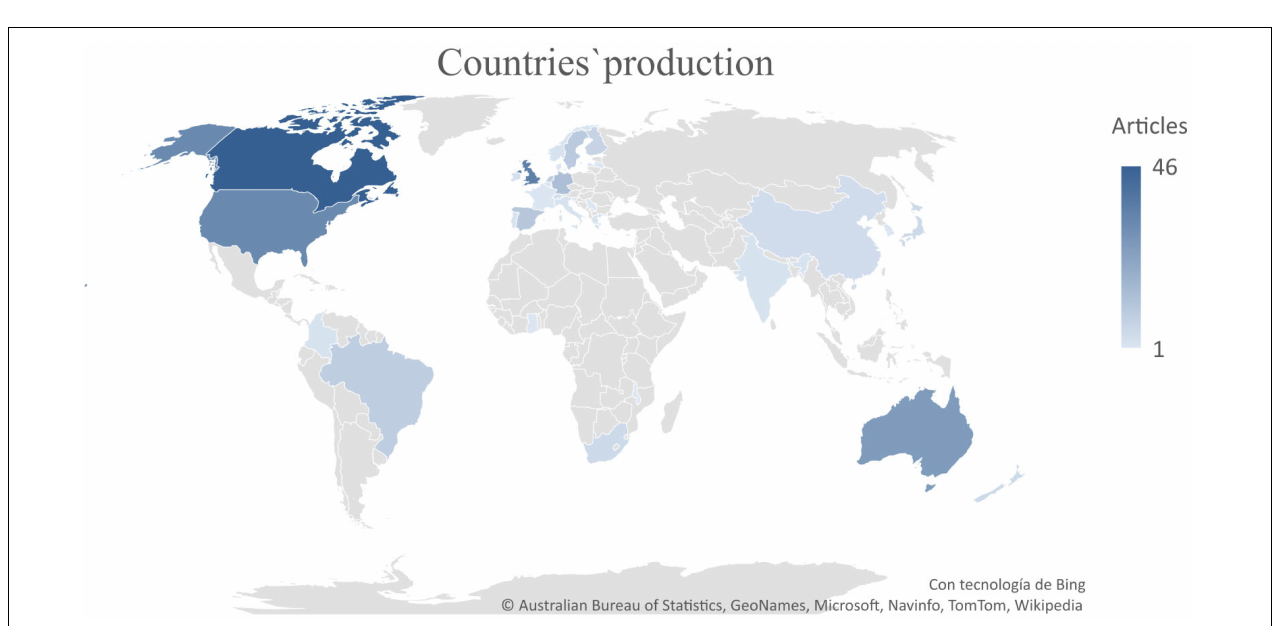
FIGURE 3 | Production by country (prepared by